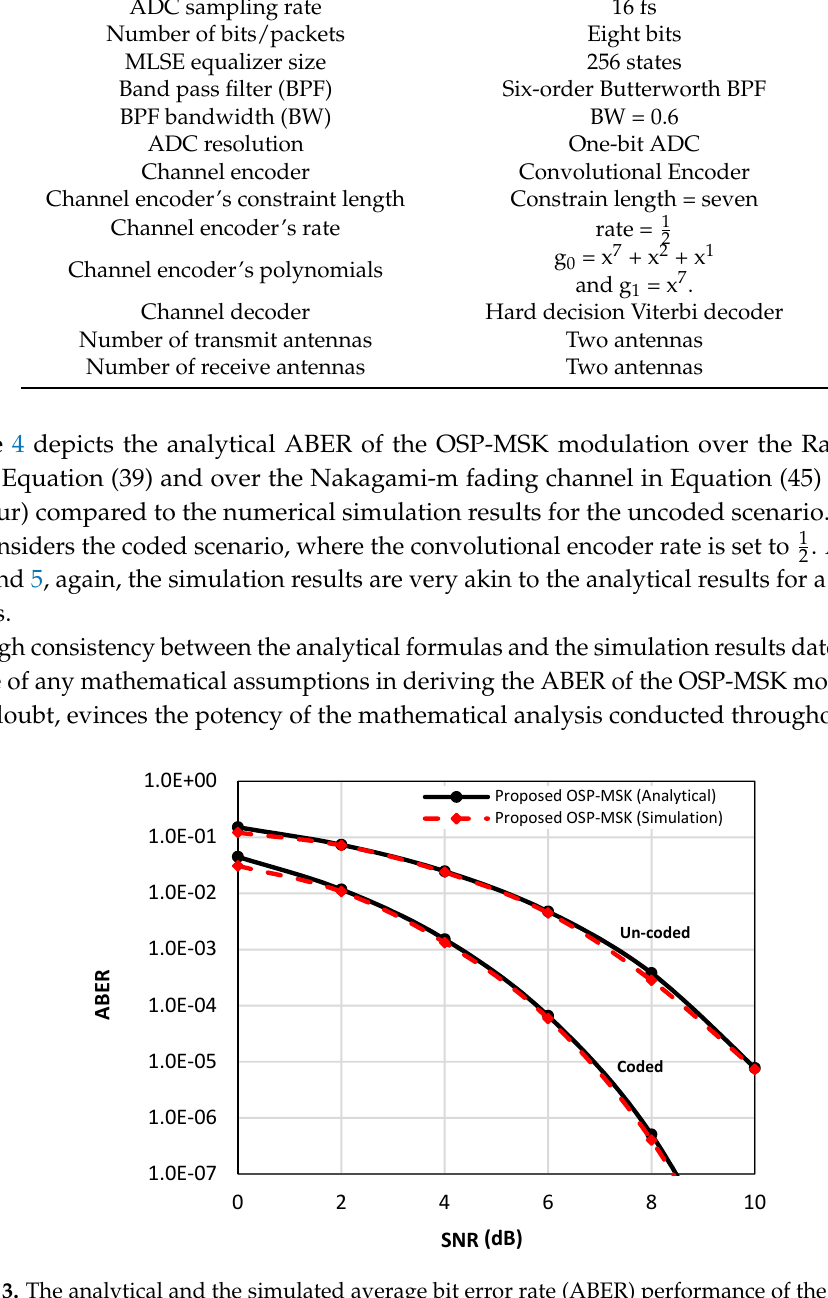
Figure 3. The analytical and the simulated average bit error rate (ABER) performance of the OSP-MSK modulation over additive white Gaussian noise (AWGN) for the uncoded and coded scenarios.